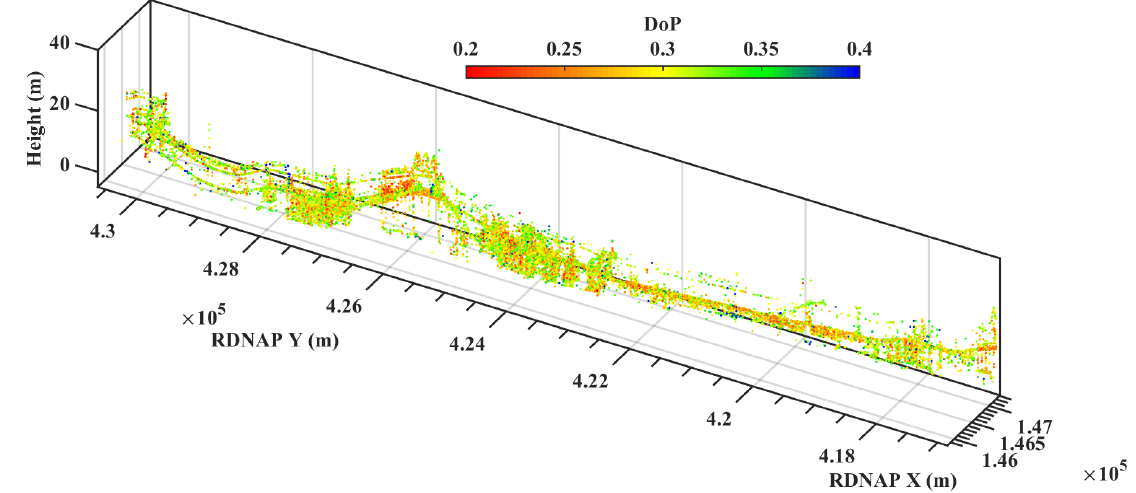
Figure 9. DoP values of radar scatterers with correct coordinates, showing the qualities of different